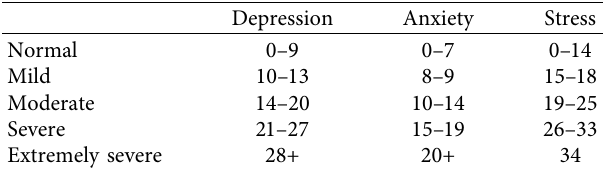
Table 1: Items of depression, anxiety, stress scale-21 with their respective